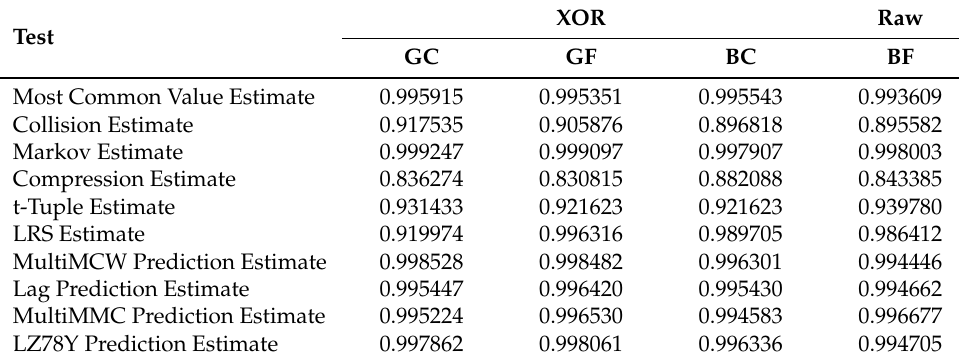
Table 7. Entropy estimation of four TRNGs using the statistical tests included in NIST 800-90b recommendation for Non-IID-track.